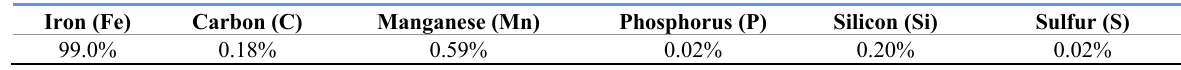
Table 1. Approximate composition of CA-50 steel.